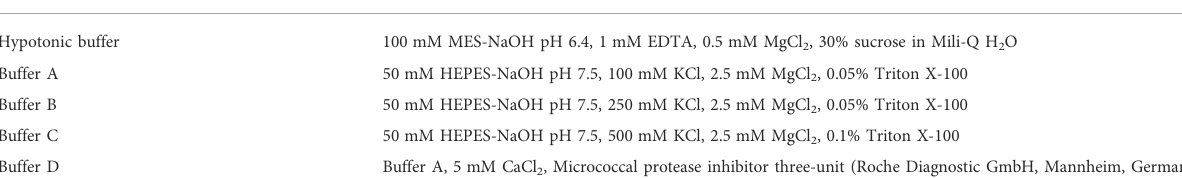
TABLE 2 Composition of trapping assay buffers. Buffer Ingredients Hypotonic